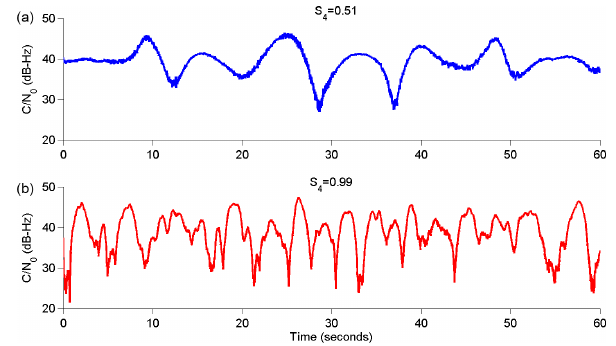
Figure 1. Two examples of observations measurements with S 4 = 0 . 51 (a) and S 4 = 0 . 99 (b) made in Cachoeira Paulista, illustrating the variability in the fading strength.